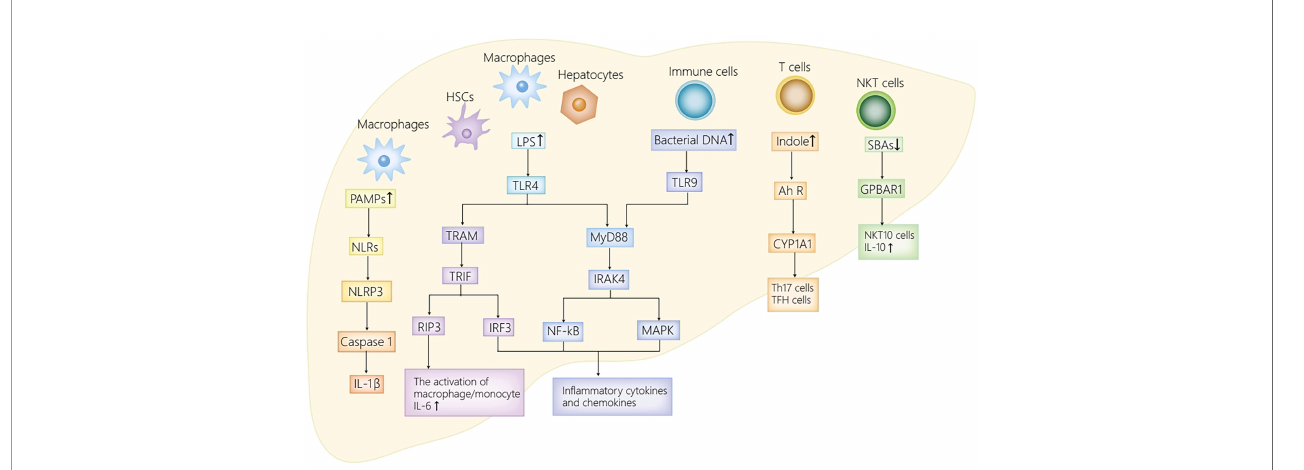
FIGURE 2 | The receptor pathways in the liver. The activation of NLRs by PAMPs activates NLRP3 in fl ammasome, thus promoting caspase-1 cleavage as well as IL-1 b secretion. TLR4 expressed on HSCs, Kupffer cells and hepatocytes enhances in fl ammatory chemokines and cytokines secretion by activating IRF3, MAPK and NF-kB. Moreover, LPS also stimulates TLR4 on macrophages to initiate RIP3 signaling pathway, thus mediating macrophage/monocyte activation, and promoting the secretion of IL-6. Furthermore, the activation of TLR9 in immune cells by bacterial DNA activates NF-kB/MAPK signaling axis, and with it the secretion of IL-12 and TNF- a . Ah R ligand, derived from translocated Enterococcus gallinarum , activates AhR-CYP1A1 signaling pathway, thus inducing the production of Th17 cells and TFH cells. The decrease of secondary bile acids attenuates GPBAR1-IL10 axis, and with it, the decrease of NKT10 cells and IL10. PAMPs, pathogen associated molecular patterns; NLRs, NOD-like receptors; NLRP3, NOD-like receptor protein 3; IL-1 b , interleukin-1 b ; LPS, lipopolysaccharide; TLR4/9, Toll-like receptor 4/9; MyD88, myeloid differentiation factor 88; IRAK4, IL-1R – associated kinase 4; NF-kB, nuclear factor kappa B; MAPK, mitogen-activated protein kinase; TRAM, TRIF- related adapter molecule; TRIF, TIR domain-containing adaptor inducing IFN- b ; RIP3, receptor-interacting protein kinase 3; TNF- a , tumor necrosis factor- a ; Ah R, aryl hydrocarbon receptor; CYP1A1, cytochrome P450 family 1A1; GPBAR1, G-protein coupled bile acid receptor 1; NKT cells, natural killer T cells; TFH, follicular helper T; HSC, hepatic stellate